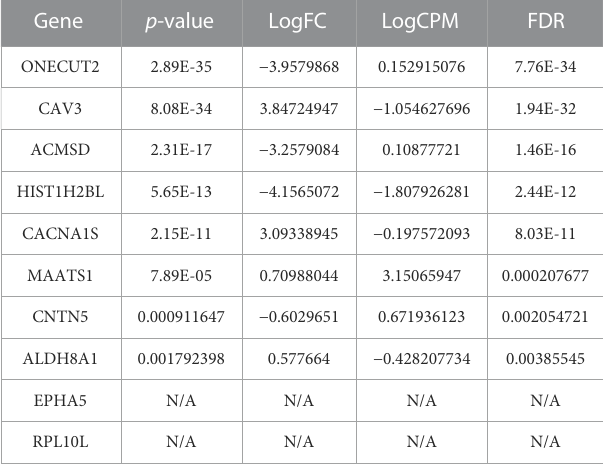
TABLE 9 The top-10 predicted therapeutic targets for lung cancer identi fi ed as DEGs and ranked based on their p -value. We also provide: FDR, an adjusted p -value, as a correction of the expression level; LogCPM (the log count per million), a measure of expression level; and logFC (the log fold-change), which is the log difference between the normal and primary tumor